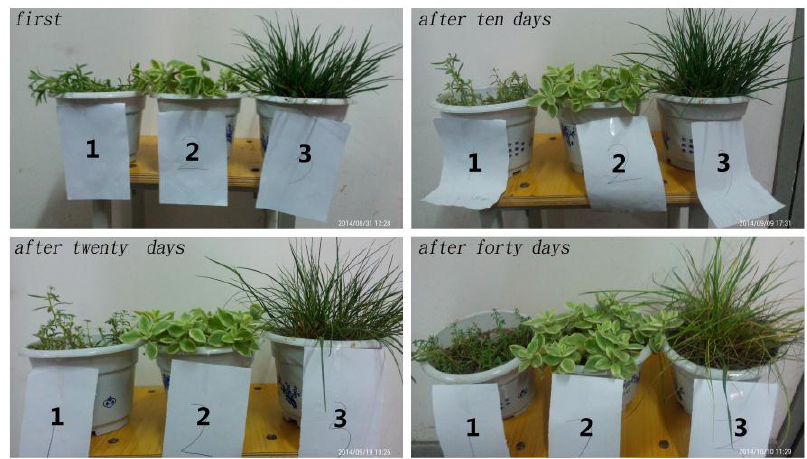
Figure 5. Trays with (1) Sedum lineare ; (2) Aptenia cordifolia and (3) Tifdwarf bermudagrass after 40 days without irrigation.